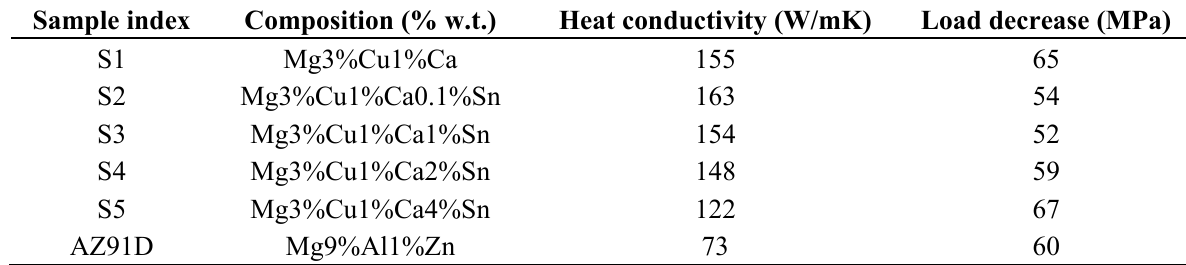
Table 1. Heat conductivities and stress decrease magnitudes for all samples tested. Sample